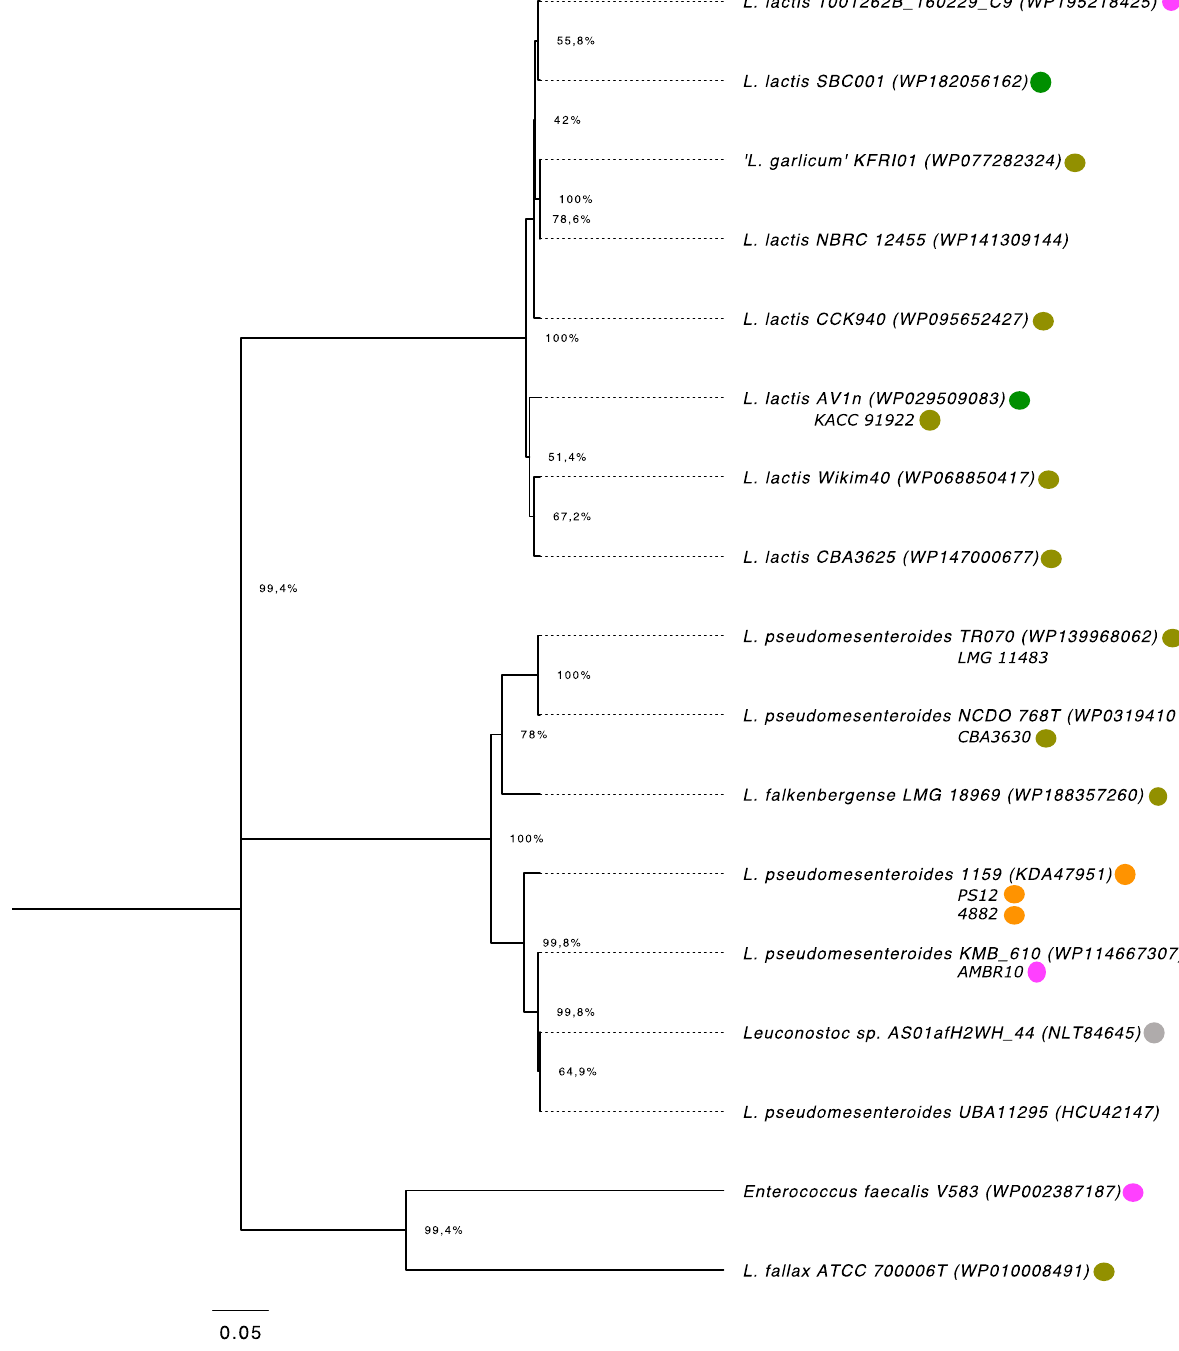
Figure 4. Distribution analysis of LsaA in Leuconostoc nontype strains. The evolutionary history was inferred using the UPGMA method [38]. The percentage of replicate trees in which the associated taxa clustered together in the bootstrap test (1000 replicates) are shown next to the branches [39]. The tree is drawn to scale, with branch lengths in the same units as those of the evolutionary distances used to infer the phylogenetic tree. The evolutionary distances were computed using the Poisson correction method [40] and are in the units of the number of amino acid substitutions per site. All positions containing gaps and missing data were eliminated (complete deletion option). Evolutionary analyses were conducted in MEGA X [41,42]. Colors refer to isolation sources: Green: raw plant material; Grey: environmental samples, Olive green: fermented foods; Orange: dairy products; Pink: clinical isolates.